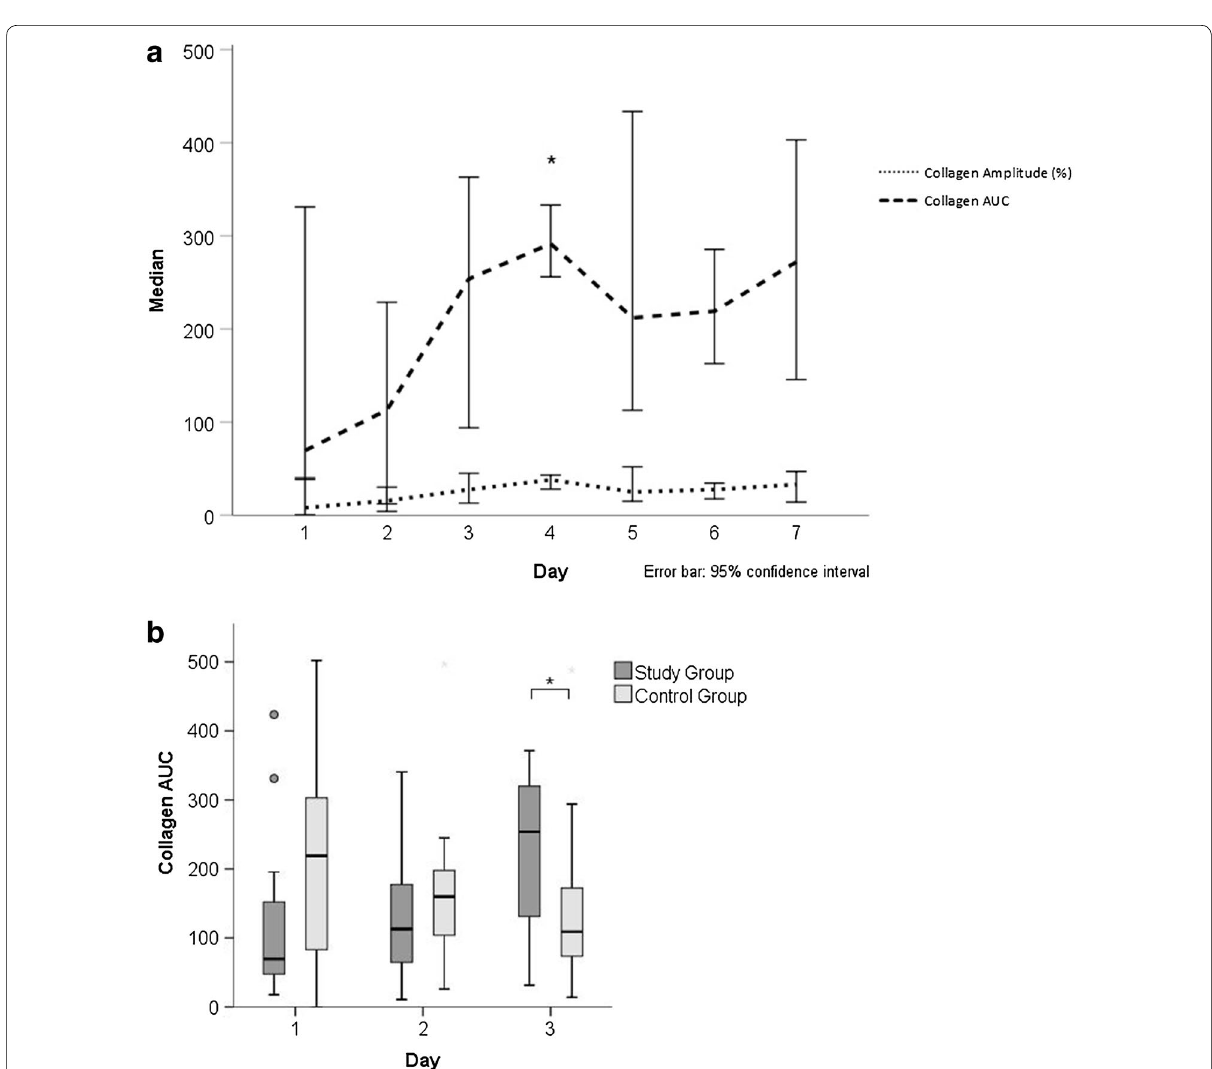
Fig. 2 Median collagen AUC and amplitude for the first 7 days after admission in the study group ( a ) and comparison of AUC in study group and control group during the first 3 days ( b